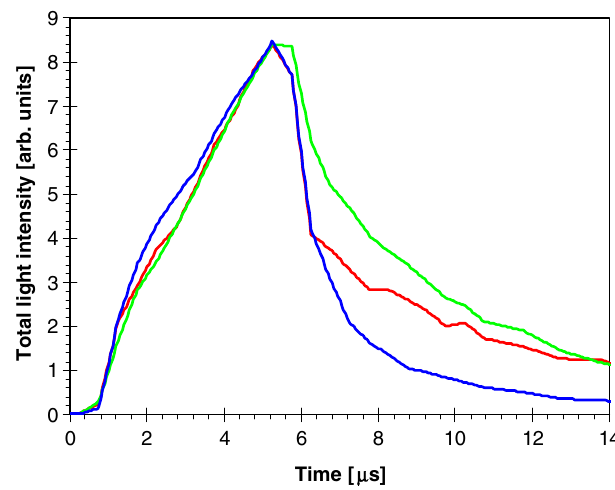
FIG. 9. (Color) Line-integrated light profiles in red, green, and blue—total emission from the entire cloud. The relative inten- sity of the three colors has been normalized to the peak